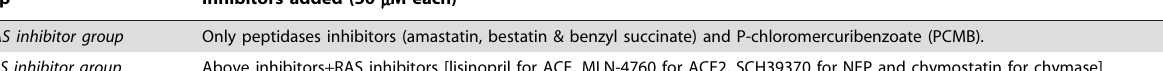
Group Inhibitors added (50 m M each) No RAS inhibitor group Only peptidases inhibitors (amastatin, bestatin & benzyl succinate) and P-chloromercuribenzoate (PCMB). All RAS inhibitor group Minus RAS inhibitor